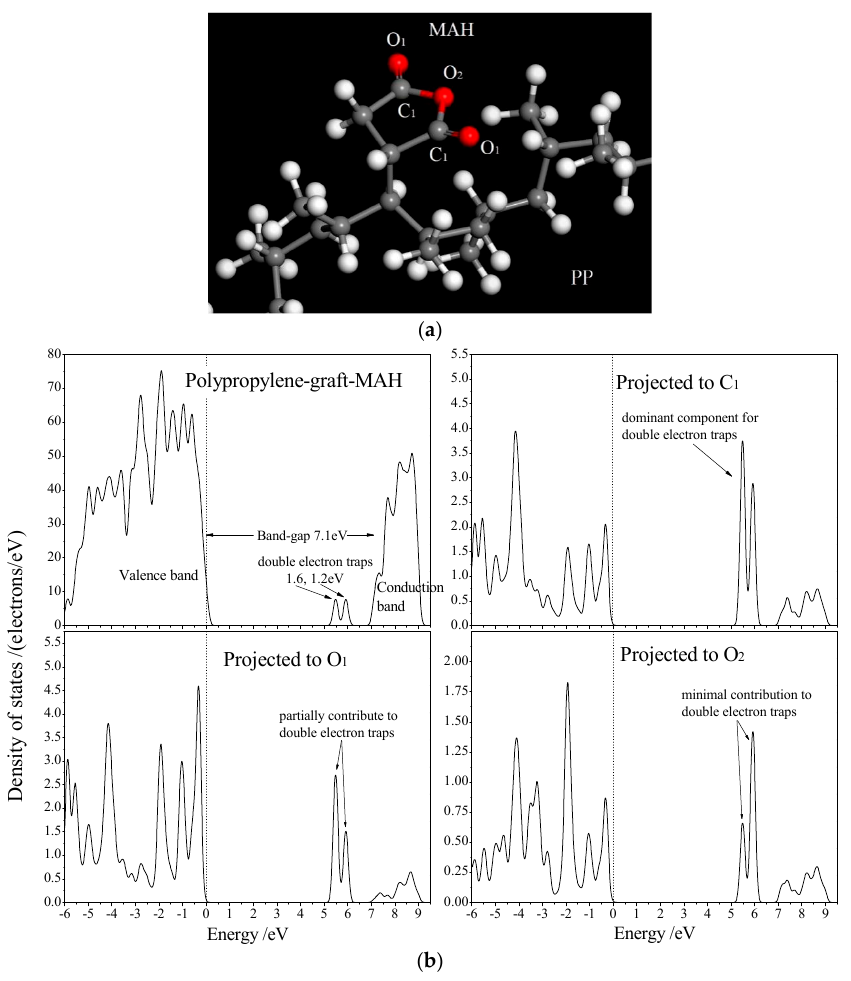
Figure 10. ( a ) Schematics of grafting MAH to polypropylene with different oxygen atoms being identified by O 1 , O 2 , and C 1 ; ( b ) the total and O-projected density of states for PP-graft-MAH from first-principles calculations.